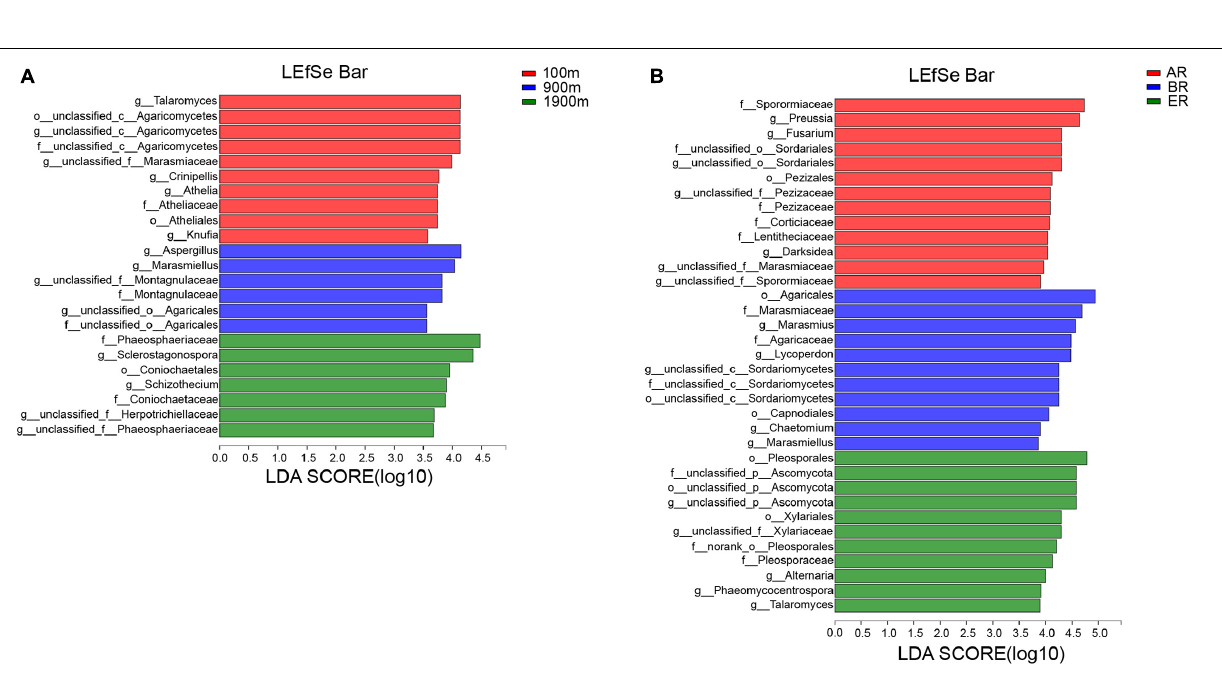
Frontiers in Microbiology |